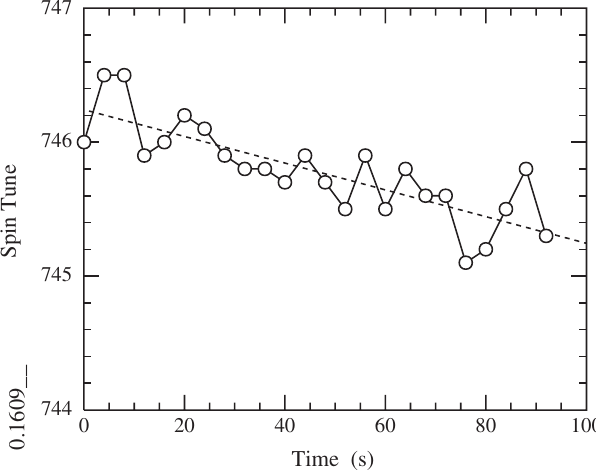
FIG. 6. Values of the spin tune chosen by the analysis program for each of a series of 4-second time bins in a machine cycle. For simplicity, the first four digits of the spin tune are noted in the lower-left corner, so the Y-axis ranges from 0.1609744 to 0.1609747. The individual points are connected with a line to guide the eye. See the text for further discussion of the dashed trend line and the scatter in these